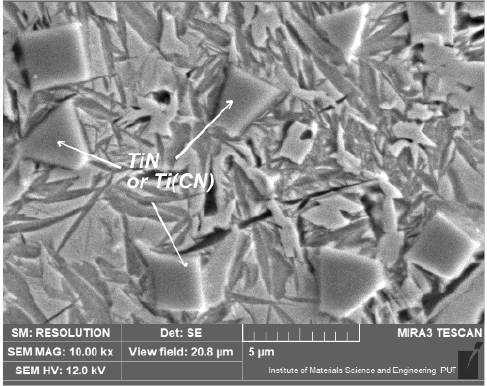
Figure 16. Microstructure of nodular cast iron surface layer, after laser alloying with titanium (scanning electron microscope, etched with nital 3%) .